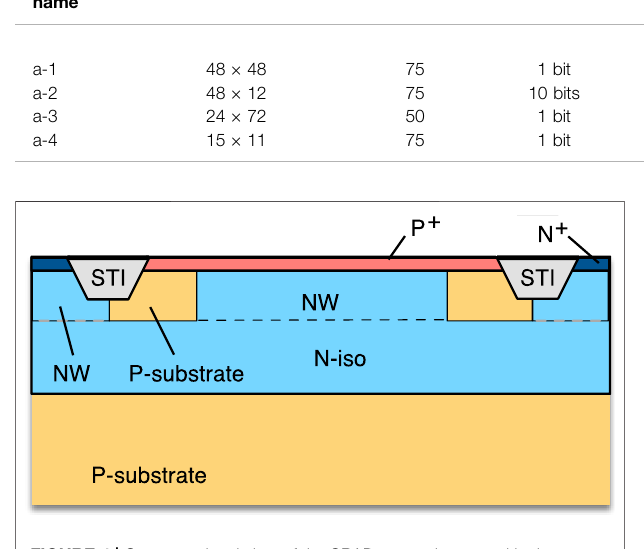
FIGURE 4 | Cross-sectional view of the SPAD sensor integrated in the FATHER and SON